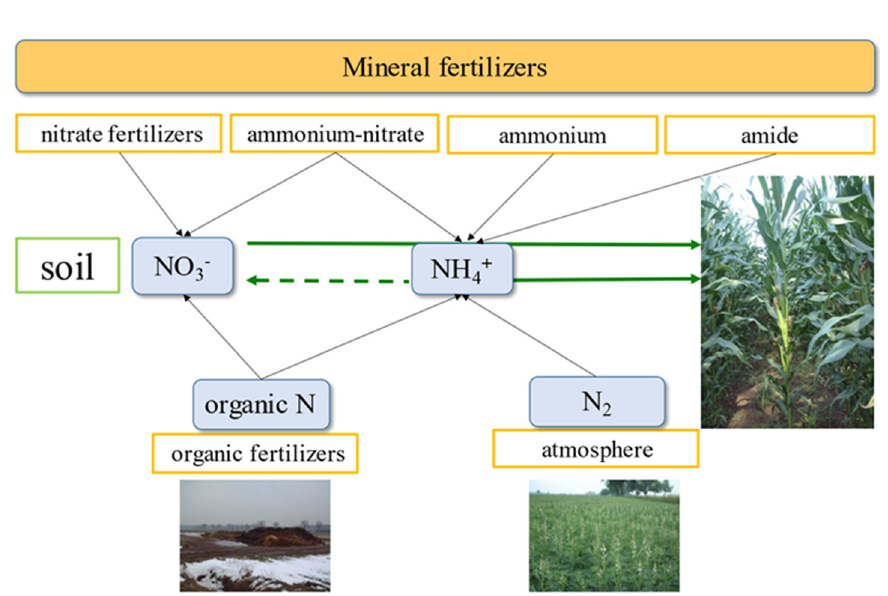
Figure 1. A simplified diagram of the nitrogen (N) cycle on the farm. Legend: gray arrows—sources of N in the soil/plant system; green arrows—inorganic forms of N taken directly by the plant; dashed green arrow—path of ammonium transformation.